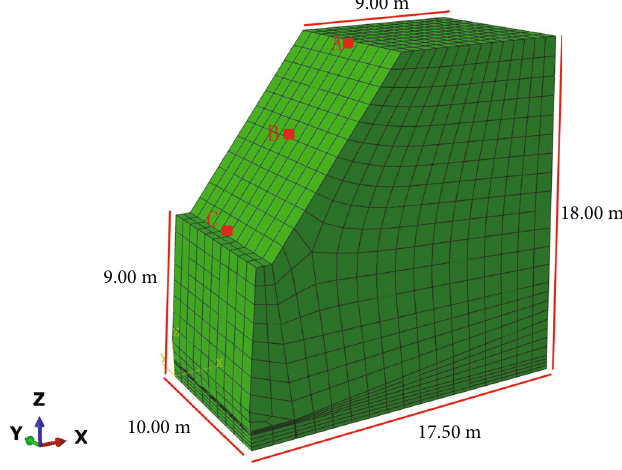
Figure 10: Numerical model of slope with retaining wall.